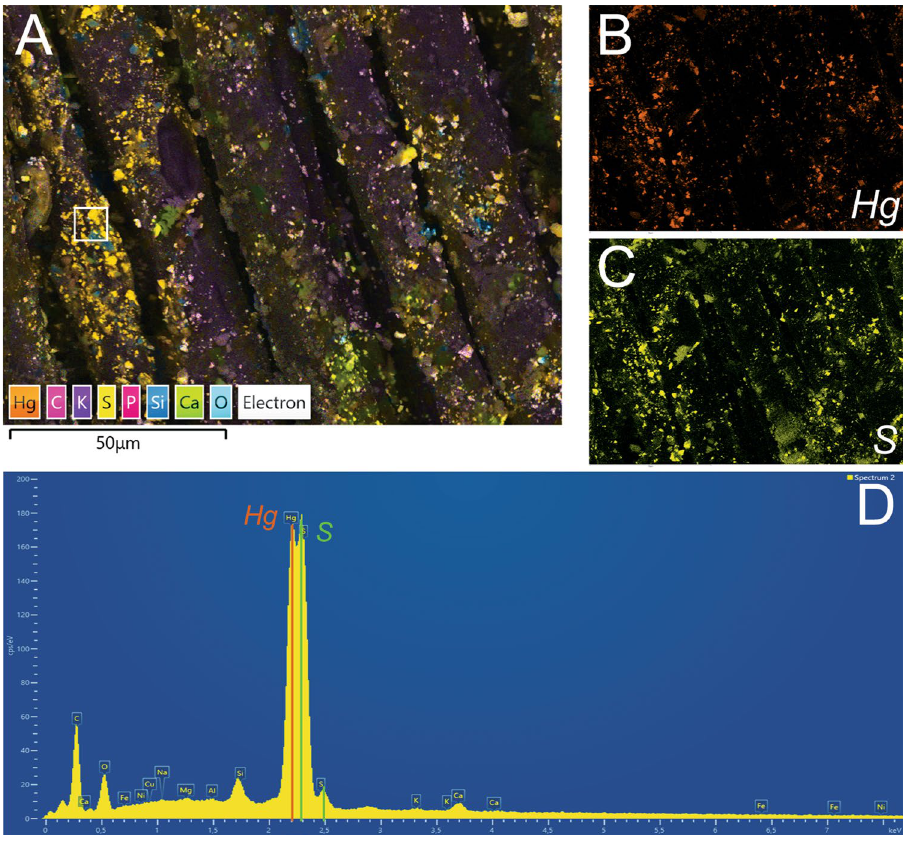
Figure 5. Elemental composition analysis of warp sample from Textile 5: ( A ) composite EDS elemental map; ( B ) EDS elemental map of Hg (mercury); ( C ) EDS elemental map of S (sulphur); ( D ) spectrum of the composite EDS map.